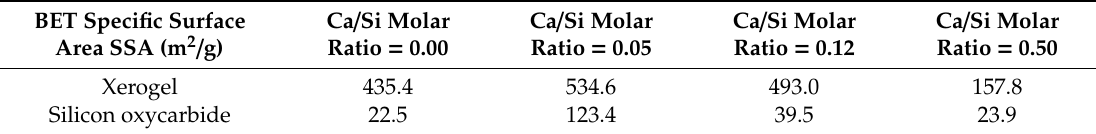
Table 4. BET specific surface area (SSA) values calculated for xerogel samples and silicon oxycarbide samples from N 2 sorption